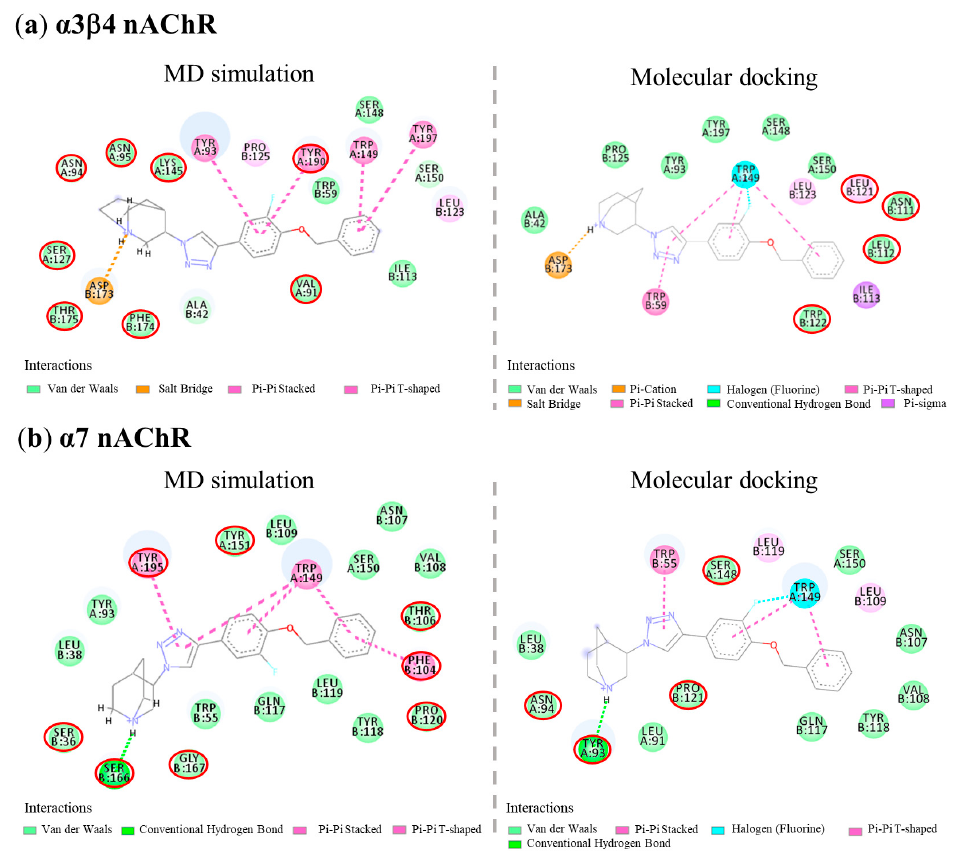
Figure 6. The binding modes of AK3 to ( a ) α 3 β 4 nAChR and ( b ) α 7 nAChR from MD simulation compared to molecular docking. A and B indicate principal and complementary subunits, respec- tively. Red circles indicate different interacting amino acid residues between MD simulation and molecular docking.